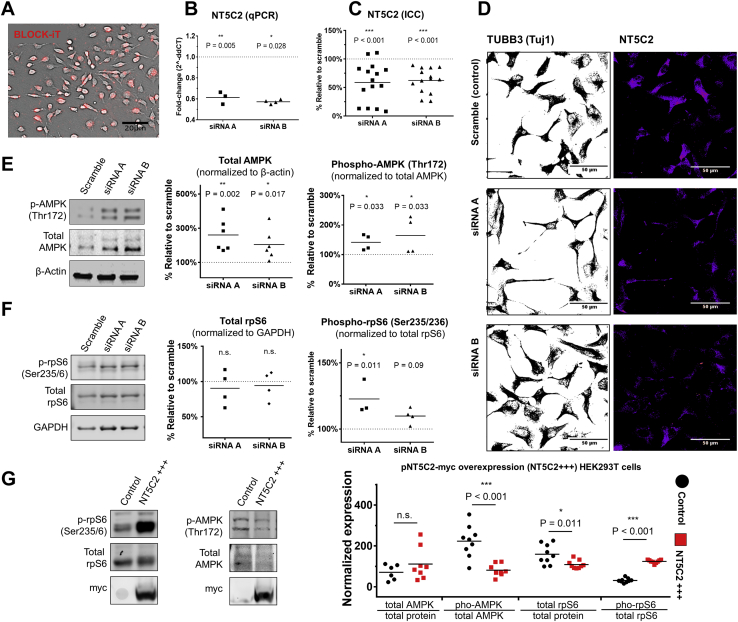
Knockdown of NT5C2 in human neural progenitor cells is associated with differential phosphorylation of adenosine monophostate-activated protein kinase (AMPK) and ribosomal protein S6 (RPS6). (A) The efficiency of the small interfering RNA (siRNA) transfection was determined by uptake of BLOCK-iT, a fluorescently labeled oligonucleotide. (B)NT5C2 expression was significantly reduced in knockdown cultures (linear regressions covarying for biological replicates, Tukey post hoc tests, **p < .01, *p < .05). (C, D) siRNA treatments significantly reduce NT5C2 expression in independent human neural progenitor cell cultures at the protein level (one-way analysis of variance, Tukey post hoc tests, ***p < .001). (E) The NT5C2 knockdown was associated with increased total AMPK alpha and phosphorylated AMPK alpha (pAMPK) (Thr172) in human neural progenitor cells (Kruskal-Wallis test, Dunn’s post hoc tests, **p < .01, *p < .05). (F) The knockdown did not alter total RPS6 levels but was associated with increased phosphorylated RPS6 (prpS6) (Ser235/Ser236). siRNA A was associated with a mean 23% increase in phosphorylation (Kruskal-Wallis test, Dunn’s test, *p < .05), and siRNA B was associated with a modest 10% mean increase, which was not significant after correction (p = .09). Full blots for panels (E and F) are available in Supplemental Figure S8. (G) The overexpression of NT5C2 in human embryonic kidney 293T (HEK293T) cells causes a significant decrease in phosphorylated AMPK alpha levels and in total RPS6, and a significant increase in phosphorylated RPS6 (t test, ***p < .001, *p < .05). Full blots are available in Supplemental Figure S9. ddCt, delta-delta cycle threshold; ICC, immunocytochemistry; n.s., not significant; qPCR, quantitative polymerase chain reaction.